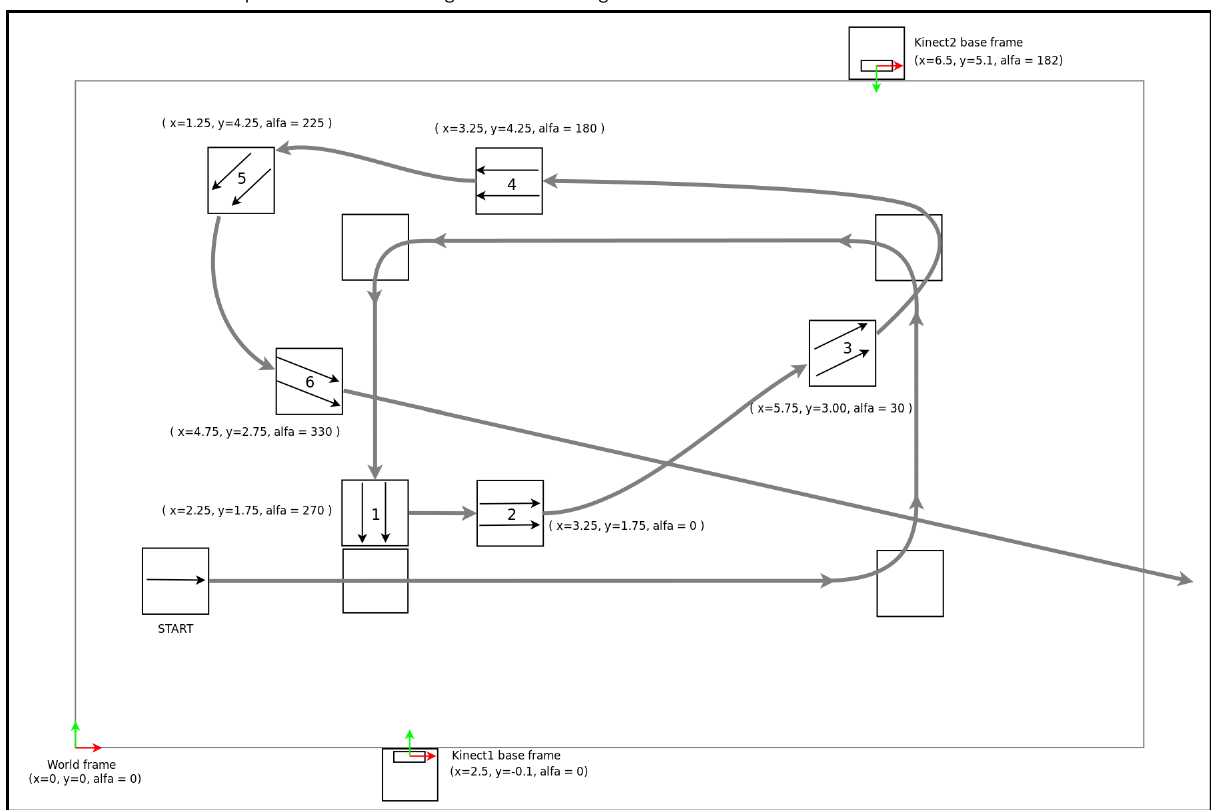
Figure 9. Schematic of marker positions and numbering for walks starting from the left side.